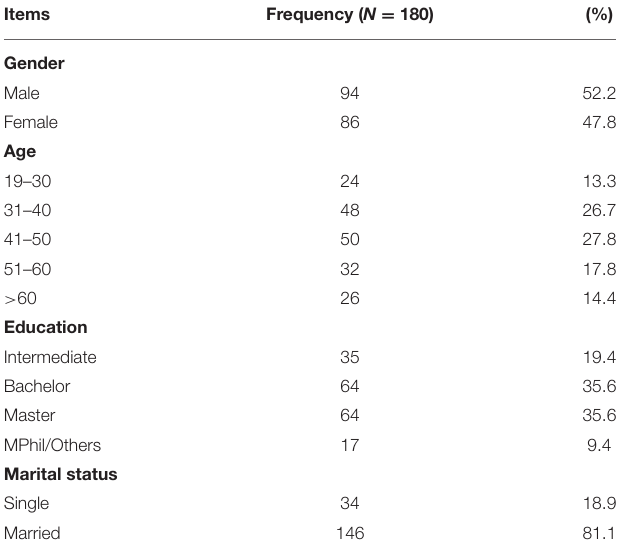
TABLE 1 | Demographic